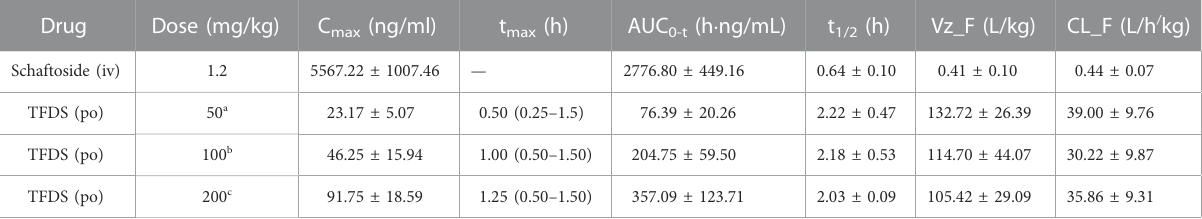
TABLE 3 Pharmacokinetic parameters of schaftoside in rats after intravenous bolus of schaftoside solution or oral administration of TFDS suspension (n = 6). Data are presented as the mean ± standard deviation except for T max as median (range).